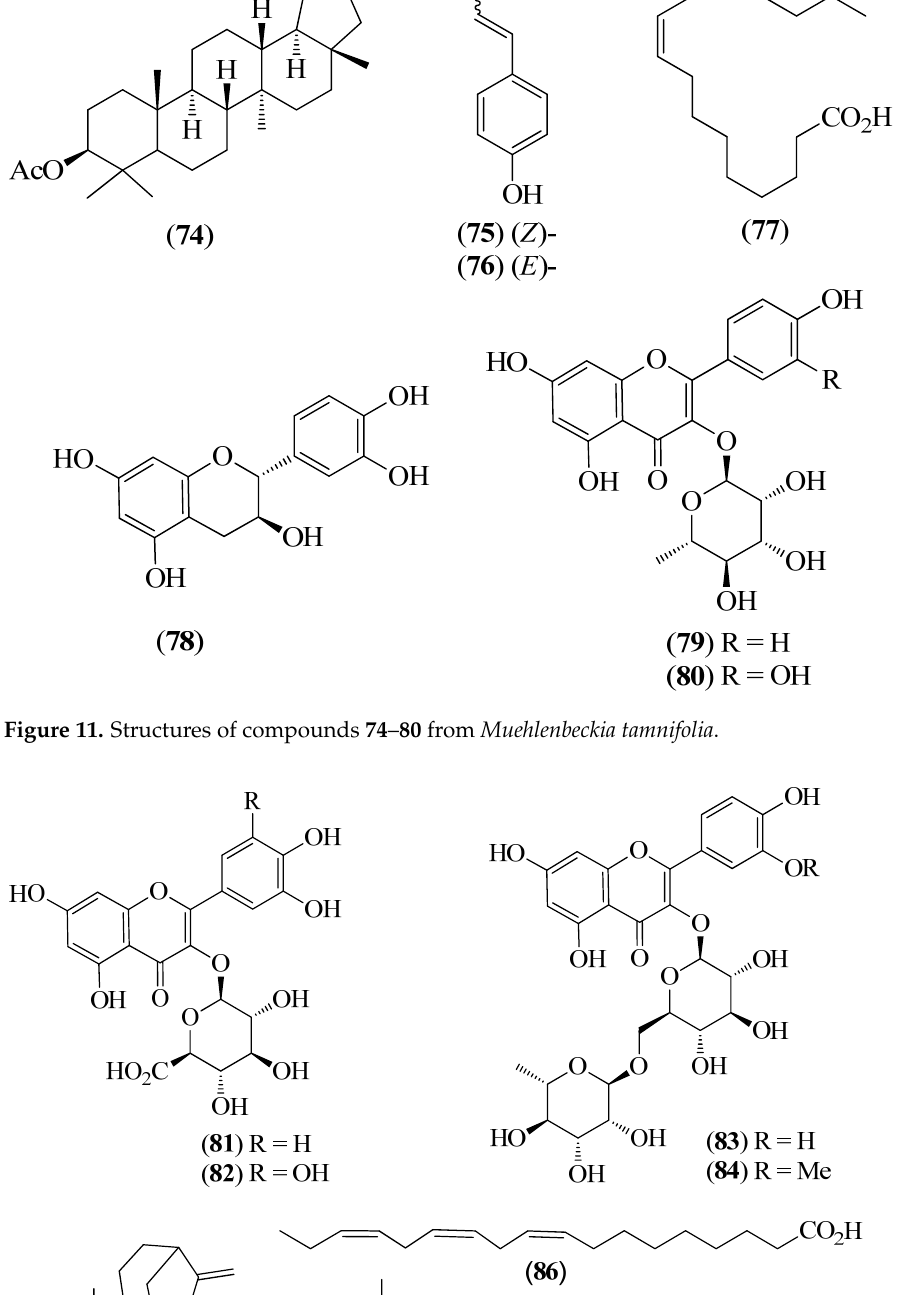
Figure 10. Structures of compounds 69 – 73 from Piper subscutatum .